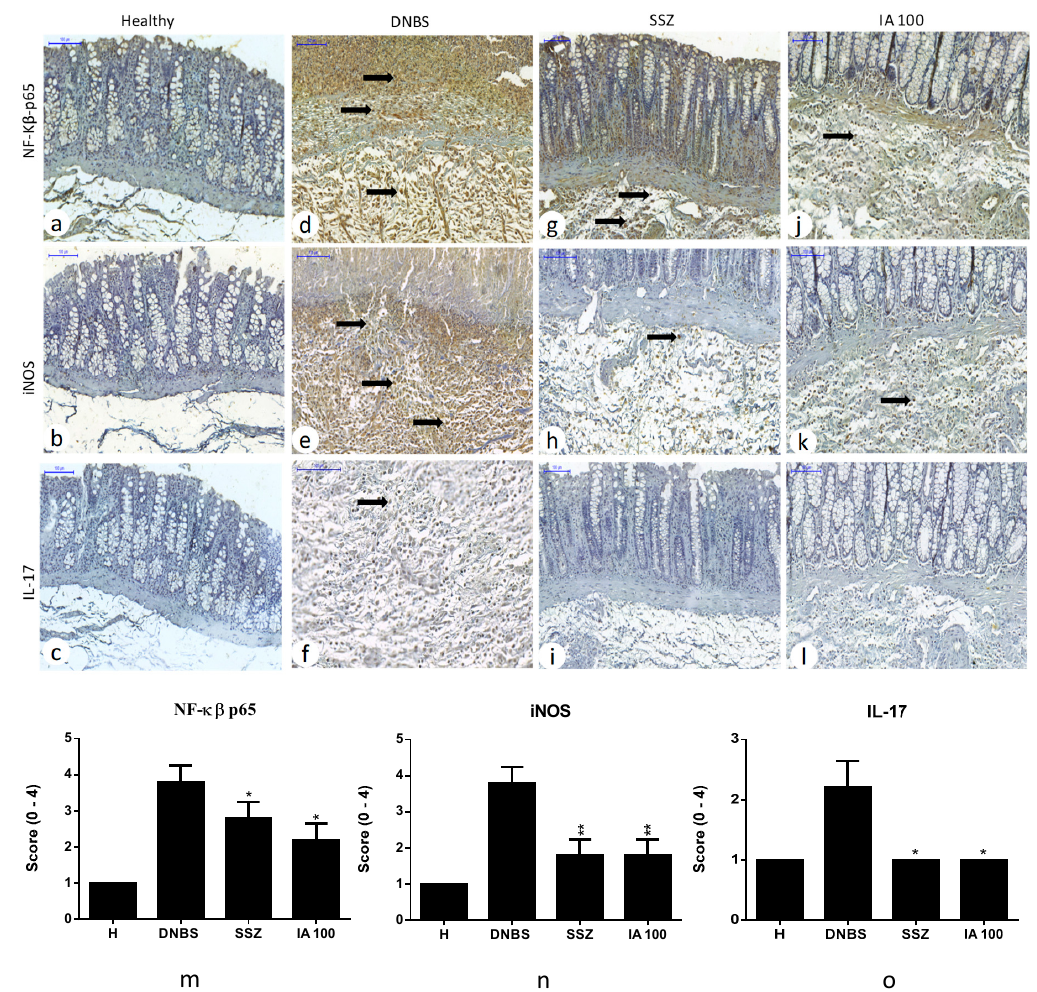
Figure 6. Immunohistochemical analysis of the effect of 25, 50, and 100 mg/kg doses of I. asarifolia (IA) aqueous extract and 250 mg/kg of sulfasalazine (SSZ) on intestinal colon mucosa in the experimental trial of acute colitis induced by 2,4-dinitrobenzene sulphonic acid (DNBS) in rats. Immunoreactivity was recognized by brownish staining in inflammatory cells, regardless of whether it was in the nucleus or cytoplasm. Healthy group without immunostaining for nuclear factor kappa β p65 (NF- κβ -p65), inducible nitric oxide synthase (iNOS), and interleukin-17 (IL-17) ( a – c ). DNBS group ( d – f ) exhibiting intense immunoreactivity for NF- κβ -p65 and iNOS in mucosa and submucosa, and discreet for IL-17. SSZ group ( g – i ) with moderate immunoreactivity for NF- κβ -p65 and discreet for iNOS and without immunostaining for IL-17. Group IA 100 mg/kg ( j – l ) showed discreet immunolabeling for NF- κβ -p65 and iNOS and without immunostaining for IL-17. Inflammatory cells ( (cid:225) ). Immunoreactivity score ( m – o ). H, Healthy group; DNBS, DNBS group; SSZ, Sulfasalazine group; and 25, 50 and 100 mg/kg doses of IA. Expressed as mean ± SEM, ( n = 5). The statistical differences * p < 0.05 and ** p < 0.01 of treatments vs DNBS control are presented (Scanner Panoramic Viewer, 100 ×